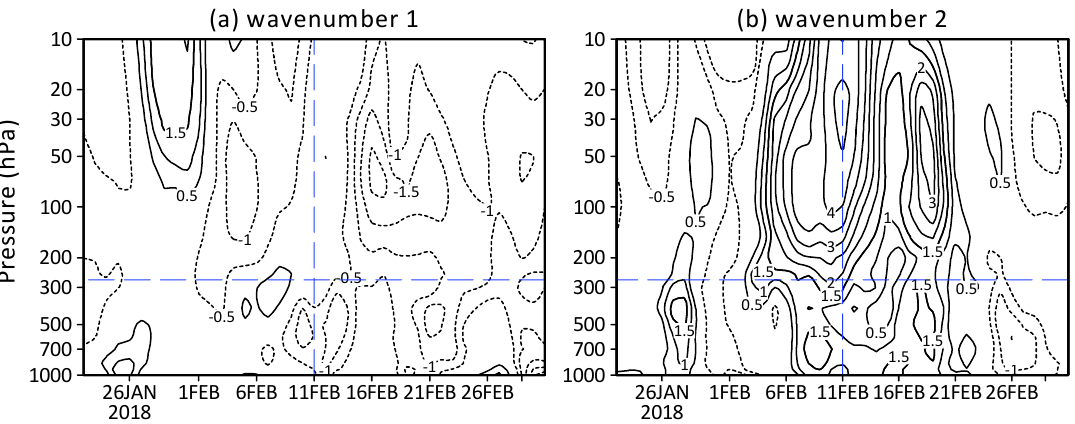
Figure 7. Temporal evolutions of standardized EP z flux in 45–75 ◦ N associated with ( a ) wavenumber 1 and ( b ) wavenumber 2. Contour interval is 0.5 with zero lines omitted. Vertical dashed lines represent the onset date of 2018 SSW event. Horizontal dashed lines represent the approximate tropopause level.